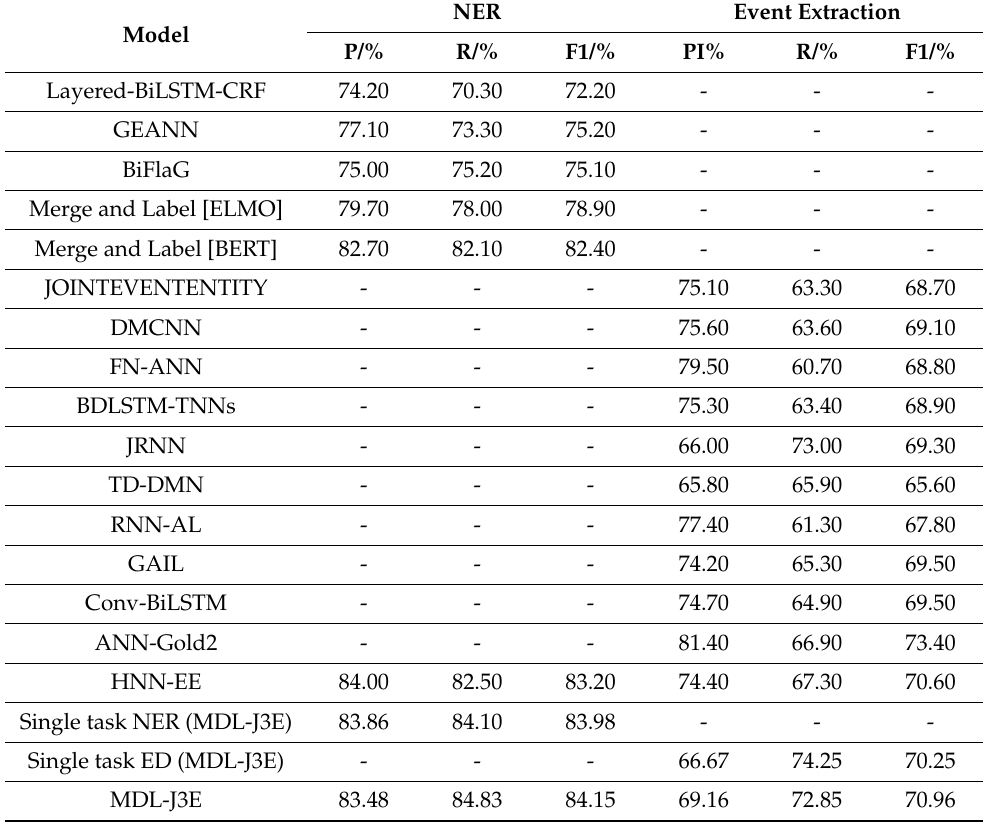
Table 3. The effects of DL